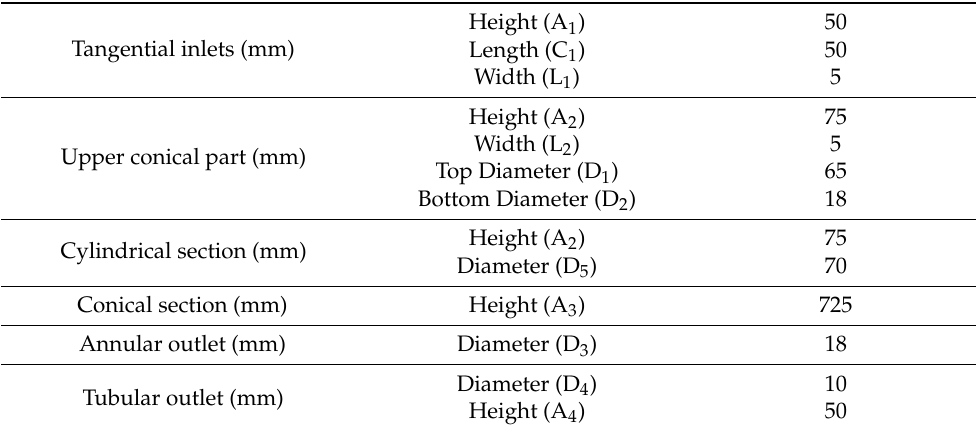
Figure 1. Schematic representation of the hydrocyclone of porous wall. Table 1. Geometrical parameters of the